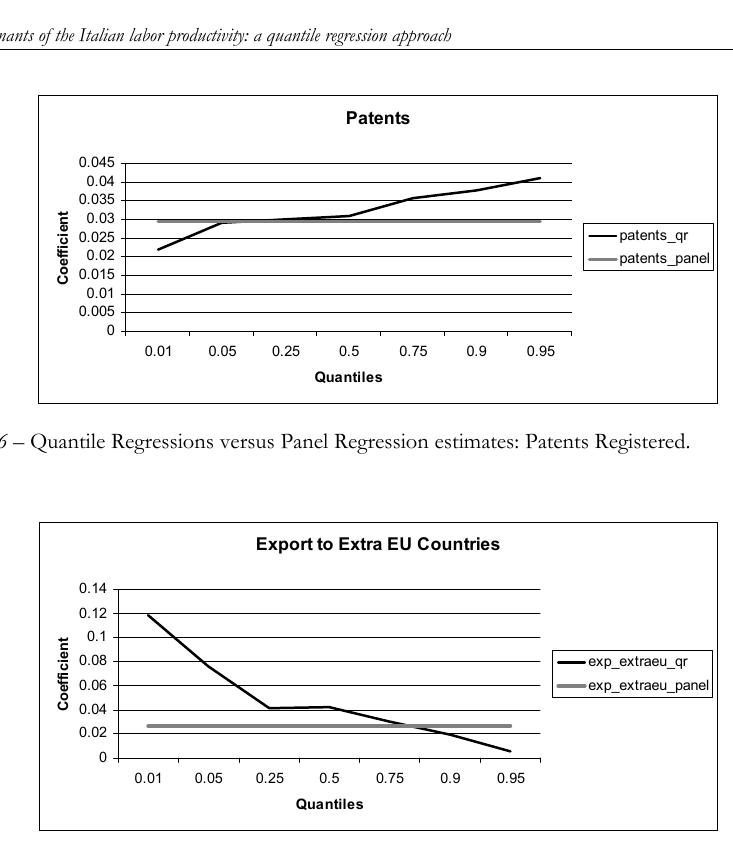
Figure 7 – Quantile Regressions versus Panel Regression estimates: Export to Countries outside the EU.